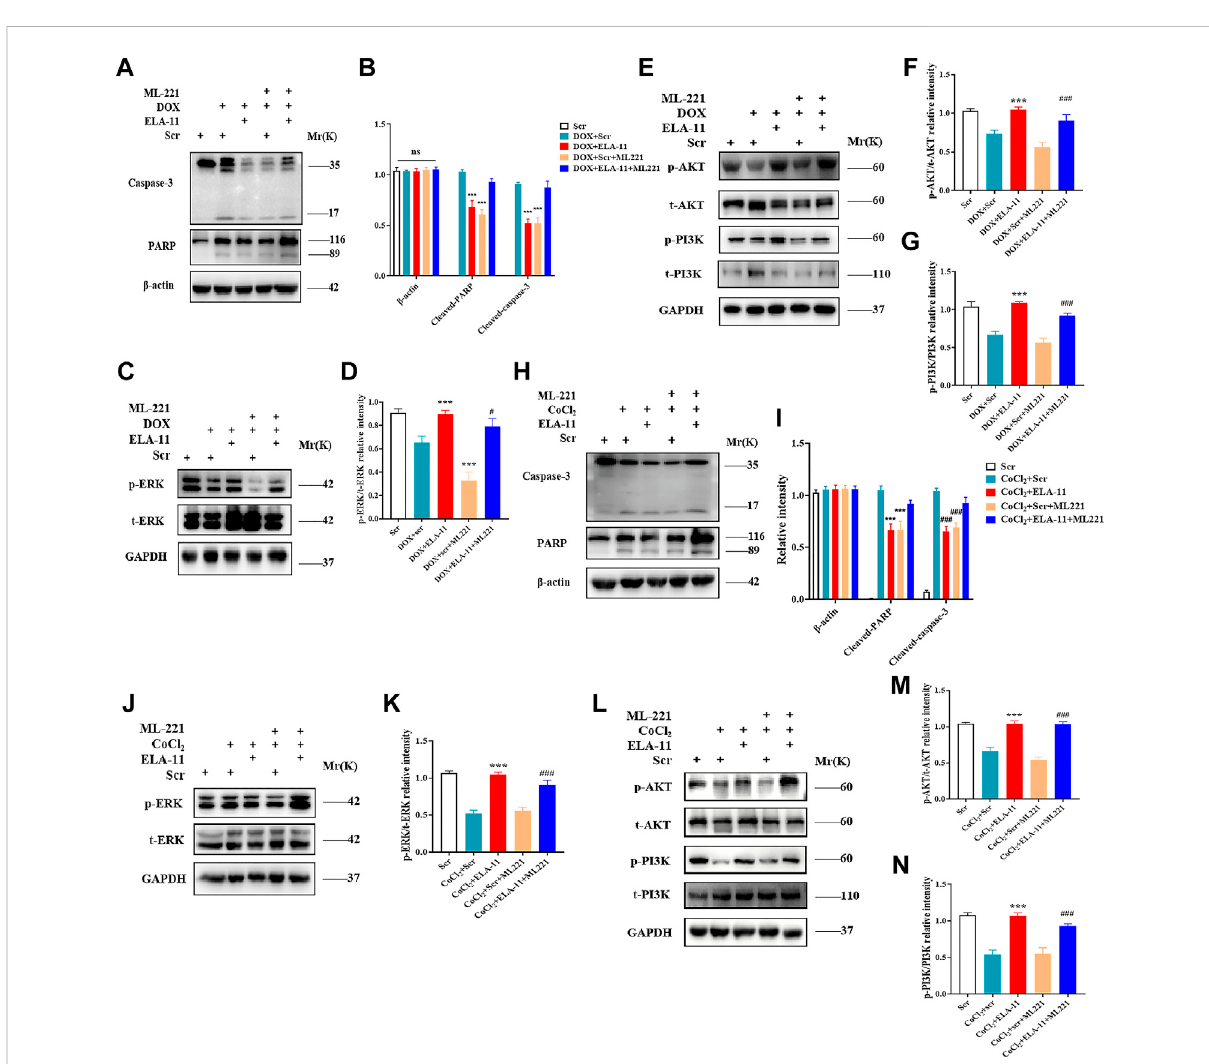
ELA-11protectscardiomyocytesbybindingAPJ. (A,B) Western blotresult ofPARPandcaspase-3withML221treatmentinDOX-inducedgroup and its quantiied data. (C,D) Western blot result of ERK with ML221 treatment in DOX -induced group and its quantiied data. (E – G) Western blot and quantiied data for PI3K and AKT in DOX-induced group. (H,I) The expression of PARP and casapse-3 in CoCl 2 -induced group by western blot and quantiied. (J,K) The expression of ERK in CoCl 2 -induced group by western blot and quantiied. (L – N) The expression of PI3K and AKT in CoCl 2 -induced group with quantiied data. *** p < 0.001, and ### p < 0.001, one-way